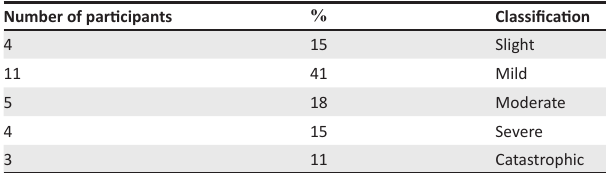
TABLE 2: Percentage of overall disability and the classification according to the Tinnitus Handicap Inventory ( N = 27).